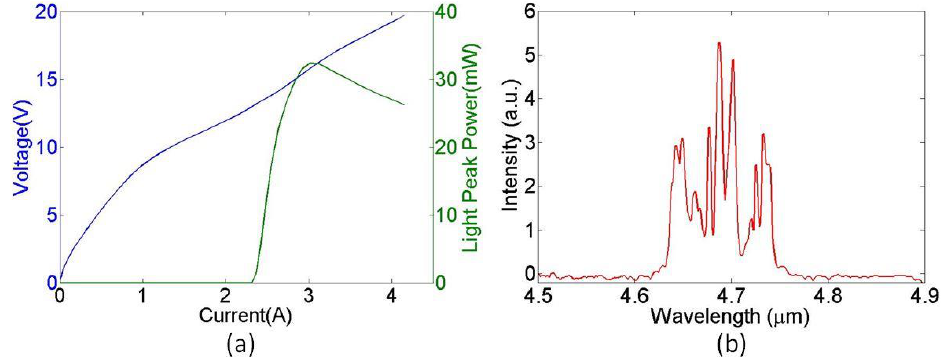
Figure 5. ( a ) LIV curve of 4 mm SSG-DBR QCL; ( b ) emission spectra for 2 mm Fabry-Pérot 4.7 μm QCLs at pumping current of 1 A.